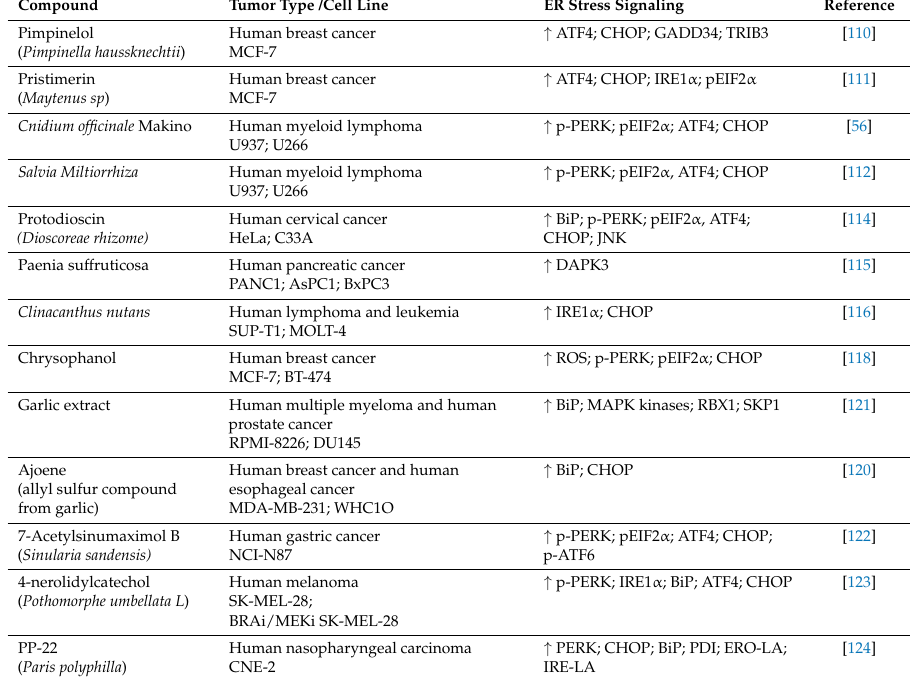
Table 6. List of different natural compounds, published in 2018, with ER stress-mediated anticancer